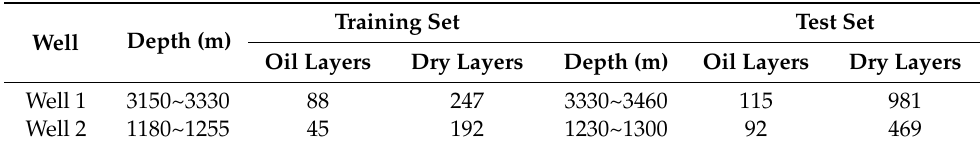
Table 4. Details of the data set division between the two wells.